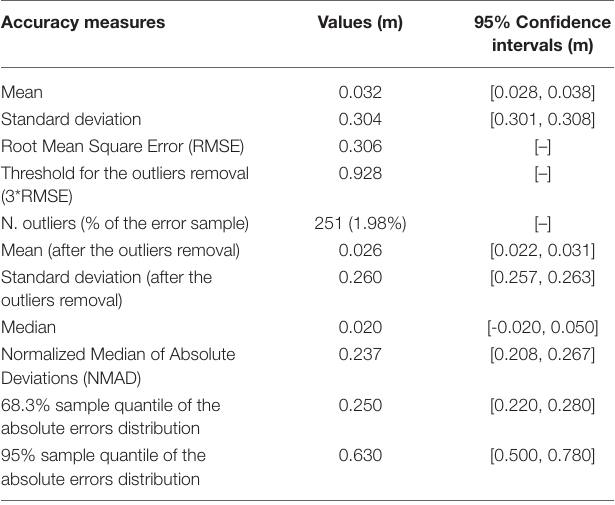
TABLE 1 | Computed standard and robust accuracy